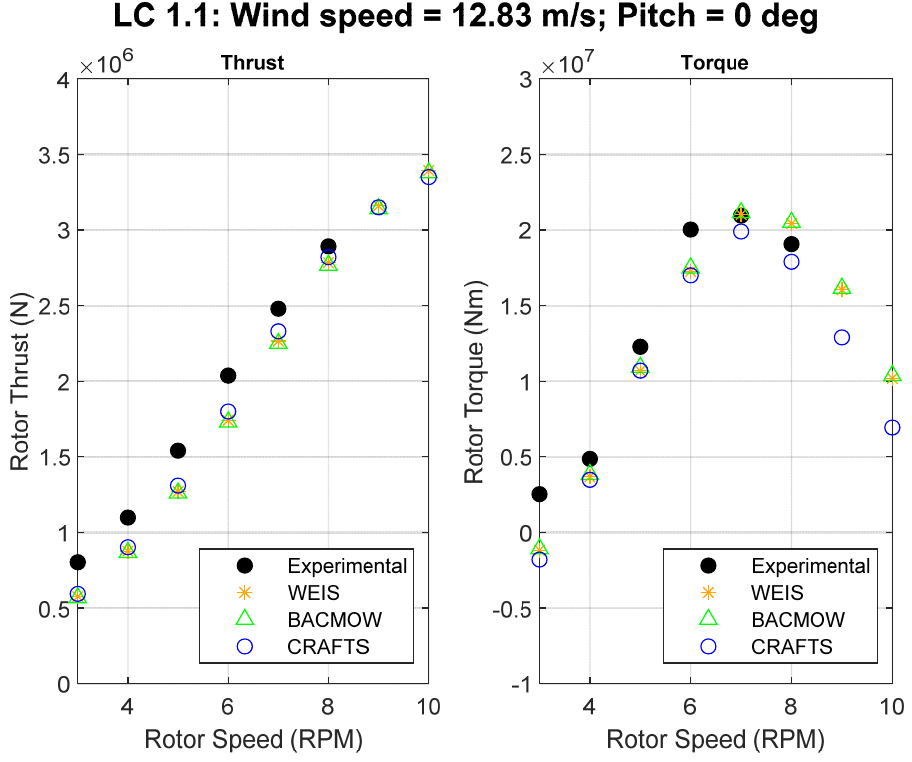
Figure 3. LC 1.1 thrust ( left ) and torque ( right ) .